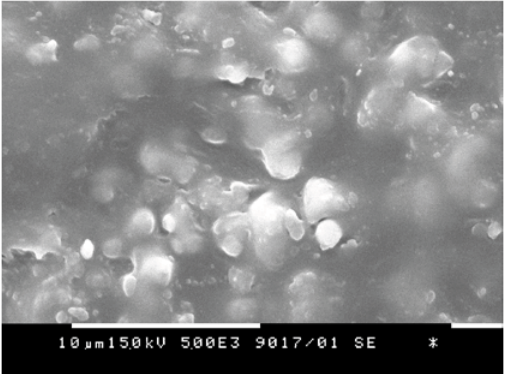
Figure 4. FTIR of the prepared hybrids in different amount of the components - 75G:25CPS/W, wt.% (a) and 25G:75CPS/W, wt.% (b) after immersion in 1.5 SBF for 3